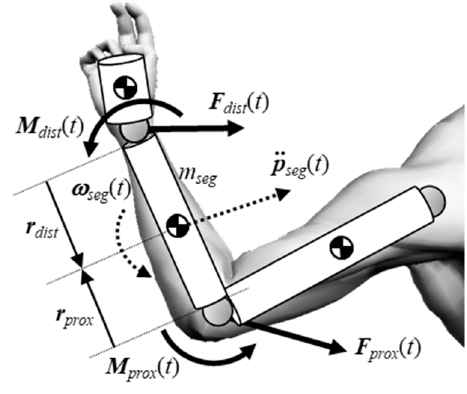
Figure 2. Joint reaction force and joint moment by inverse